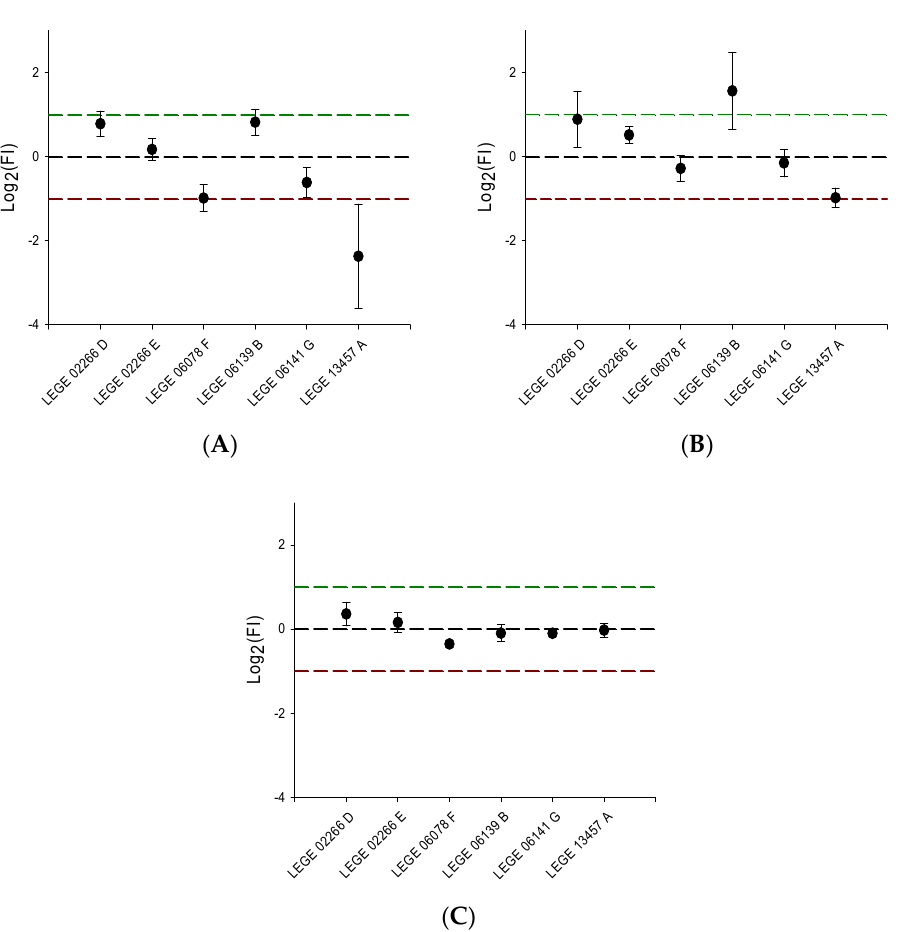
Figure 5. Transactivation activity observed in cells transfected with mpFN26A[Fluc]/mpGL4.35[Nluc] sensor system, in uniplex mode in PPAR α ( A ), PPAR β ( B ), and PPAR γ ( C ). These six cyanobacteria fractions were considered hits in the two previous triplex assays using the same sensor system. Data above and below the threshold lines represent hits, with values y ≥ 1 (green line) corresponding to induction and y ≤ − 1 (red line) to repression. The basal response to the solvent control (dimethyl sulfoxide, DMSO; concentration not exceeding 0.5 % per well) is represented by the black dashed line (y = 0). Data are shown as mean ± standard error of the mean (SEM) (n = 3).